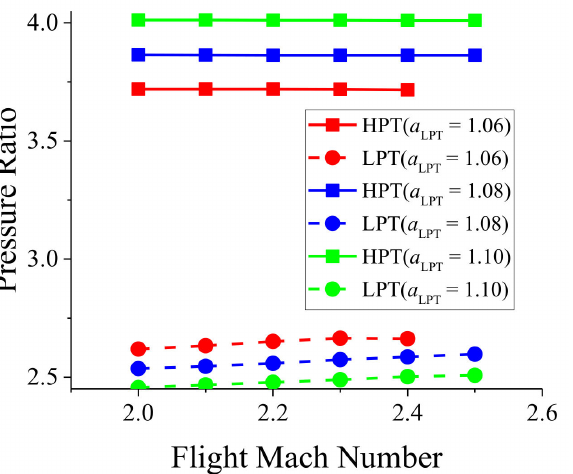
Figure 42. The Variations of Turbine Pressure Ratios at the conditions of Different Throat Area Coefficients of Low-Pressure Turbine Inlet Guide Vane ( α LPT ).